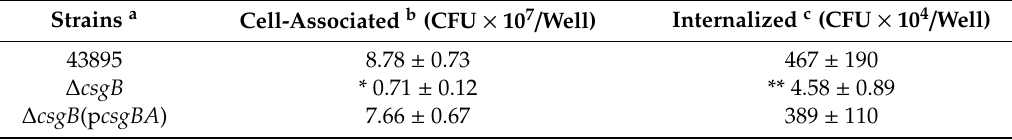
Table 3. Adherence to and invasion of MAC-T cells by O157 strain 43895 and its derivatives. Strains a